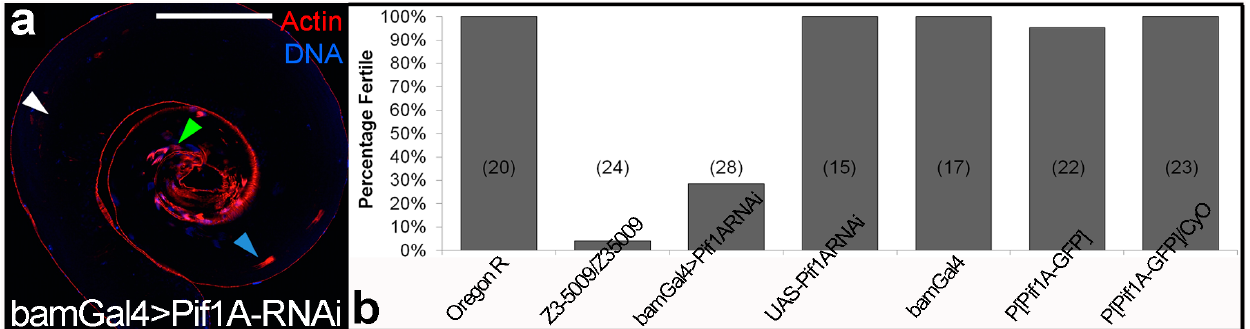
Figure 9. Spermatid individualization in bamGal4>Pif1A-RNAi testis and fertility assays. Actin cones are arrested with nuclear bundles in bamGal4>Pif1A-RNAi testis ( a ), consistent with the Z3-5009 mutant. Specifically, testes from these flies contained arrested actin cones associated with spermatid nuclei (( a ), green arrowhead) or F-actin sleeves (( a ), blue arrowhead) and no cystic bulges/waste bags are observed (( a ), white arrowhead). Phalloidin staining, red; DAPI staining, blue. A small minority of the testes of this genotype appear roughly WT as explained in the text. Fertility assays ( b )—all of the listed Drosophila lines represent males that were crossed with female virgin Oregon R flies; P[Pif1A-GFP], homozygote P[Pif1A-RI-GFP]. Numbers in parentheses refer to sample size. Error bars represent ± standard error. Bar 100 µm.